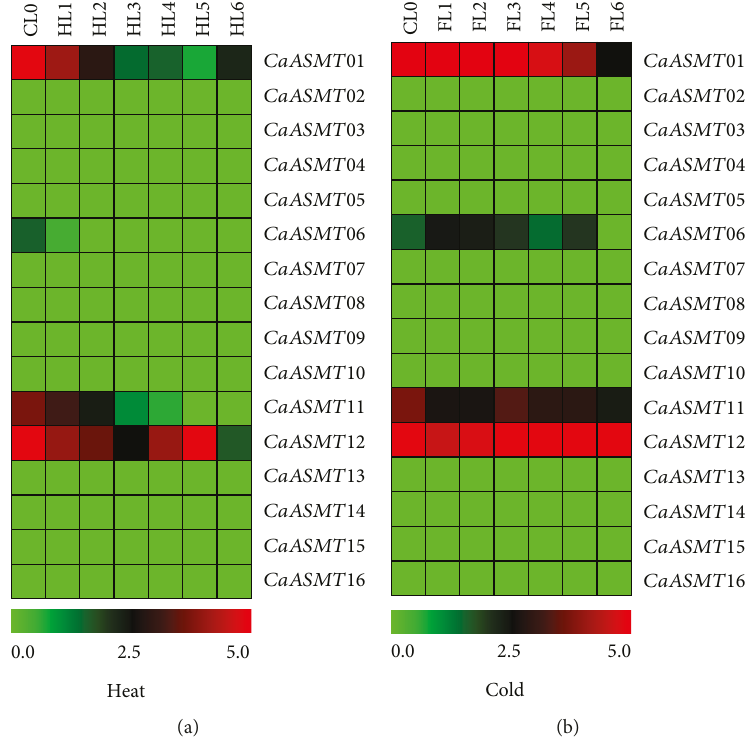
Figure 5: Expression pro fi les of CaASMT genes in response to abiotic stresses based on RNA-Seq in pepper. (a) Leaf under heat treatment conditions; (b) leaf under cold treatment conditions. Leaf tissue was collected from both heat- and cold-treated plants at 0, 0.5, 1, 3, 6, 12, and 24 hours posttreatment (HPT) and was named HL1 to HL6 and FL1 to FL6, respectively. CL0 represents the control group. All RNA-Seq datasets were obtained from the Pepper Informatics Hub (http://pepperhub.hzau.edu.cn/), and a detailed description of the samples is available from the Pepper Informatics Hub. The data were normalized based on the mean expression value of each gene in all identi fi ed tissues. Then, the log2-transformed RPKM values were used to obtain heat maps using the software MeV 4.9.0. Red and green boxes indicate the high and low expression levels of the CaASMT genes,